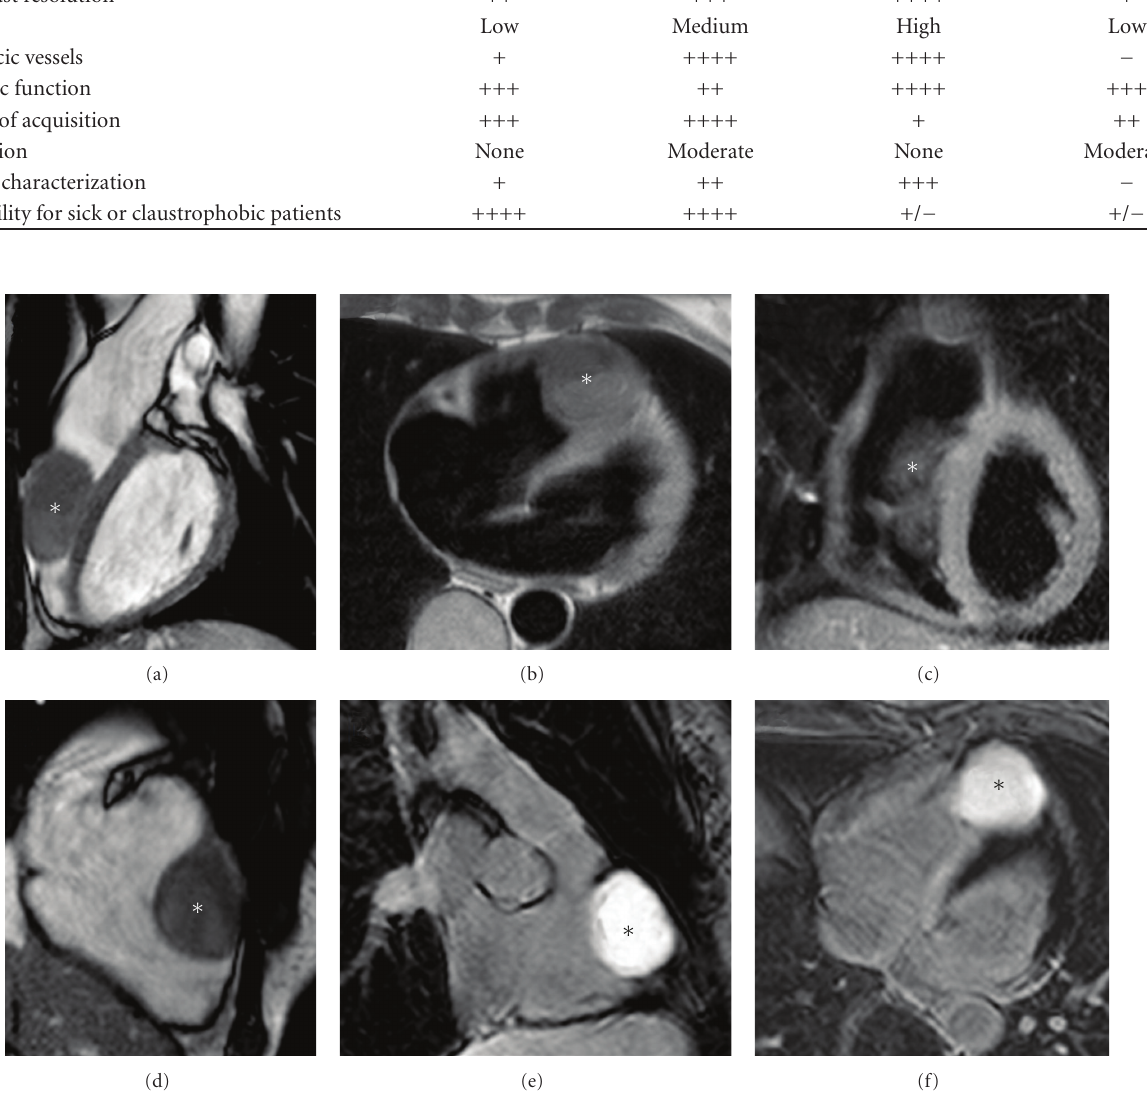
Figure 2: Fibroma. An ovoid mass partially obstructs the right ventricular outflow tract ((a)–(f), asterisk). The mass is of intermediate intensity on T1-weighted imaging ((a) and (b)) and low signal on T2-weighted imaging (c). This combination of findings would make malignancy relatively unlikely since many neoplasms have a relatively high water content and thus are high signal on T2 sequences. Dramatic contrast uptake is, however, evident on the postgadolinium images ((e) and (f)). Dense fibrous tumors may behave in this way, and the diagnosis of fibroma was later